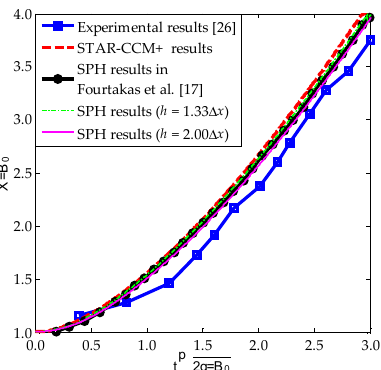
Figure 15. Comparison of the dimensionless distance from the leading edge to the right wall ( ∆ x = 0.025 m ) .